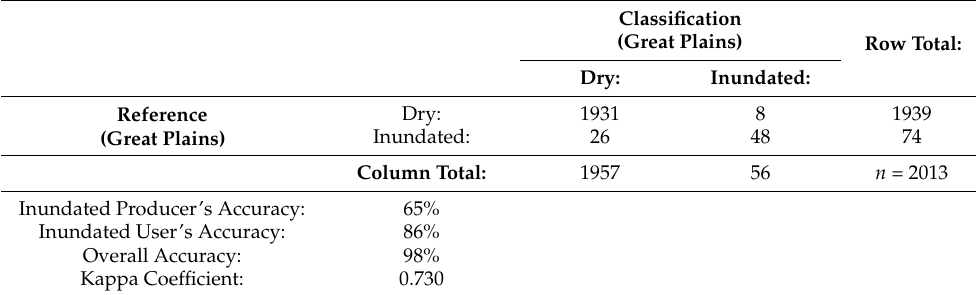
Table 6. The confusion matrix for the LandTrendr model in the Great Plains Ecoregion. The perfor- mance of the LandTrendr model when compared to manual interpretation of independent satellite imagery in the Great Plains ecoregion (the western and southwestern parts of the state). Overall accu- racy is still high at 98%, but the producer’s and user’s accuracies for the inundated class specifically are 65% and 86%, respectively. This suggests the model struggled with identifying surface water in this region more than